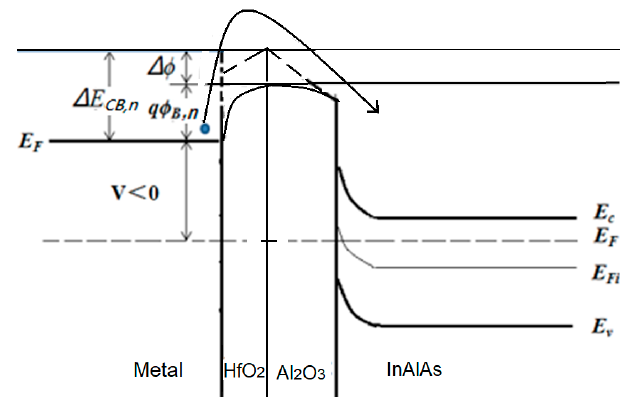
Figure 2. Schottky emission energy-band diagram for V g < 0.